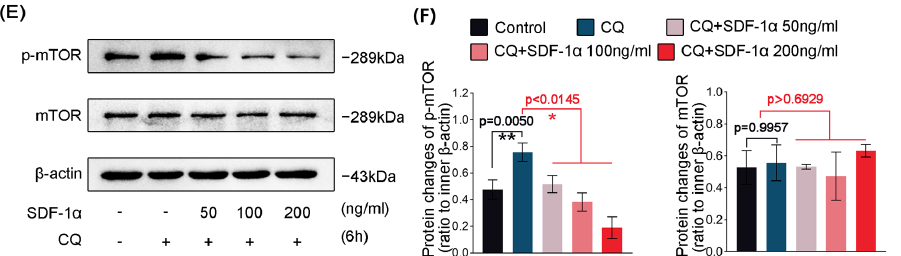
Figure 4. SDF-1 α inhibits the mTOR/p-mTOR signaling in chondrocytes ( A ) Pheatmap based on RNA sequencing indicating the mRNA changes of autophagy pathway in chondrocytes in response to SDF-1 α (200 ng/mL) for 48 h. The datasets are presented as FPKM (Fragments Per Kilobase of transcript per Million fragments mapped) by online R-package from RNA sequencing data. Three independent pairs of samples, i.e., Sample 1 and 1 ′ , Sample 2 and 2 ′ , and Sample 3 and 3 ′ , were from the same mother cells, respectively. ( B ) qPCR confirming the mRNA changes of Pih1d1, Ulk1, Becn1, Sqstm1 and Prkaa2 in chondrocytes in response to SDF-1 α (200 ng/mL). GAPDH gene was used as the inner control. ( C ) Representative western blots showing the expression of mTOR and p-mTOR in chondrocyte treated with SDF-1 α (200 ng/mL) for 6 h. ( D ) Quantitative analysis of the expression changes of mTOR and p-mTOR shown in ( C ). ( E ) Representative western blots showing the expression of mTOR and p-mTOR in chondrocyte treated with 200 ng/mL SDF-1 α for 6 h in the presence or absence of CQ (20 μ M). SDF-1 α inhibited phosphorylation of mTOR in chondrocytes in a dose-dependent manner. ( F ) Quantitative analysis of the expression changes of mTOR and p-mTOR shown in ( E ). The data shown in ( A – C , E ) are based on three independent experiments ( n = 3). Data in ( B , D , F ) are presented as the mean ± SD. The significance is based on one-way analysis of variance. * p < 0.05; ** p < 0.01; *** p < 0.001; **** p < 0.0001.